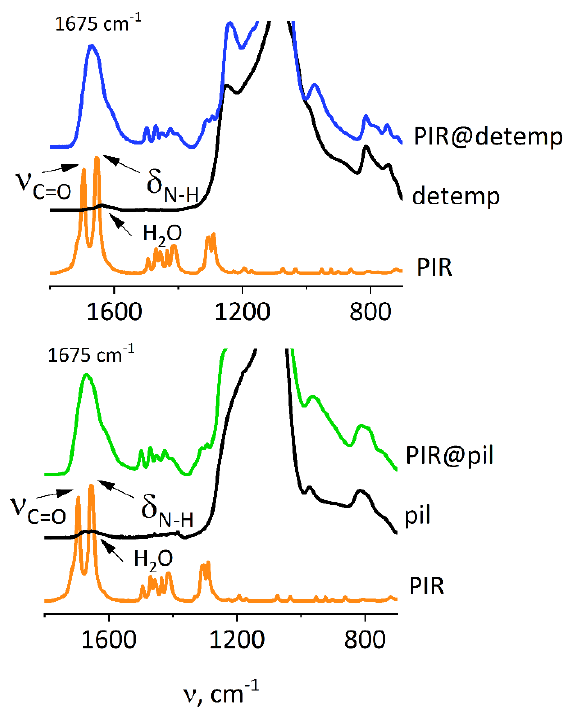
Figure 5. FT-IR spectra for detemplated (detemp) and pillared (pil) ZSM-55 intercalated with piracetam (PIR). Zeolite spectra normalized to 1090 cm −1 band (Si-O-Si vibrations), piracetam spectra normalized to the content in respective composite. Alternative representations of the data are available in supplementary material (Figure S2).